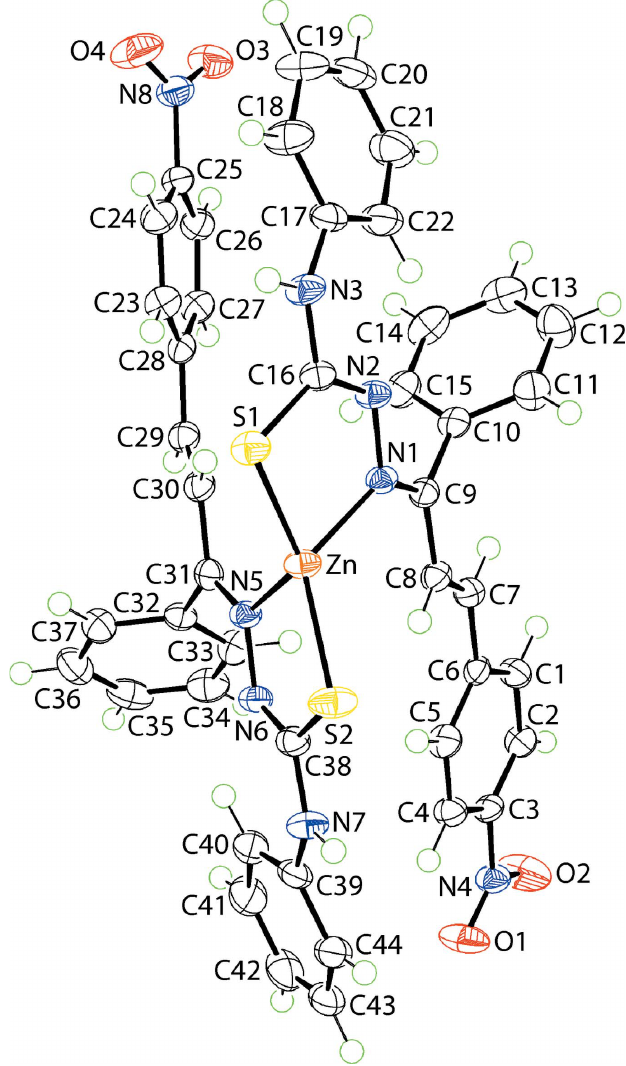
Figure 1 The molecular structure of (I) showing the atom-labelling scheme and displacement ellipsoids at the 70% probability